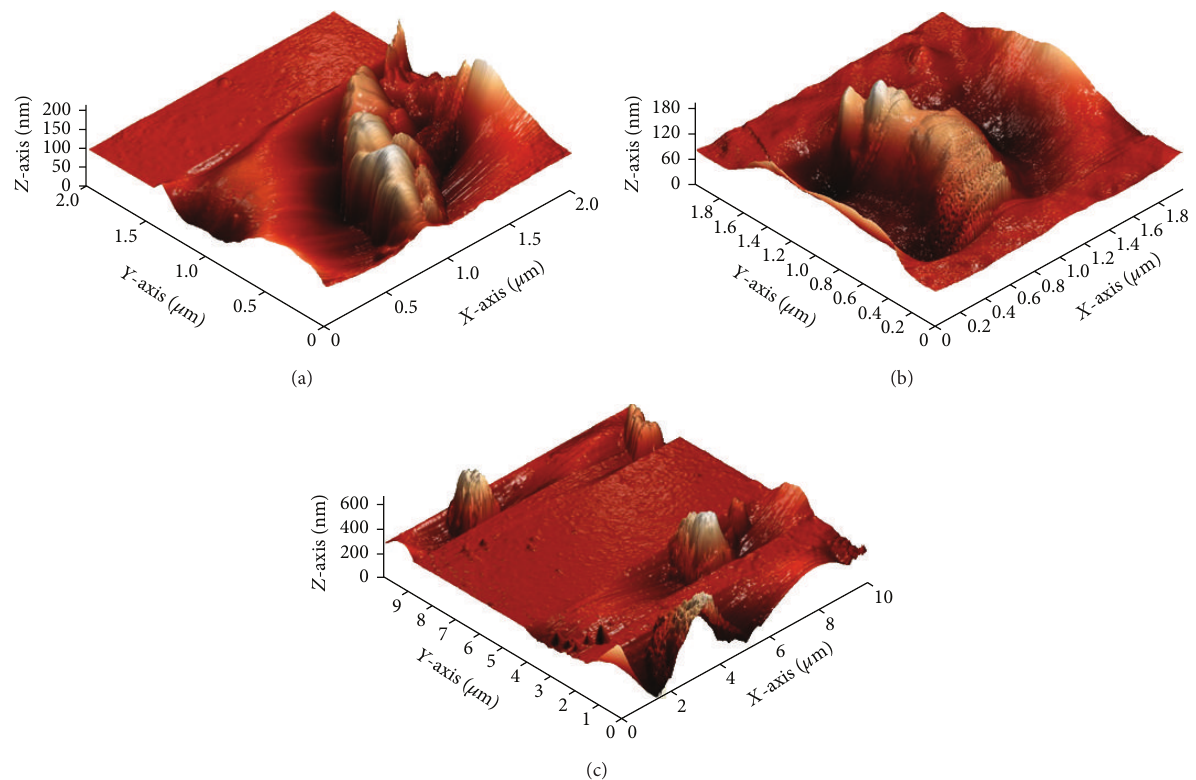
Figure 9: AFM images for CNT/TiO 2 films annealed at (a) 550 ∘ C, (b) 650 ∘ C, and (c) 750 ∘ C.